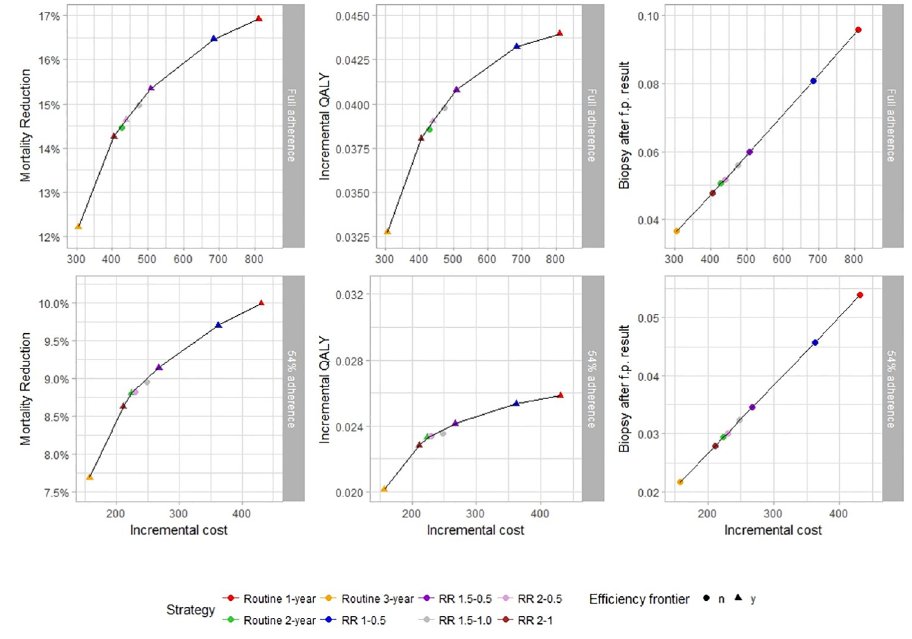
Fig 1. Cost-effectiveness efficiency